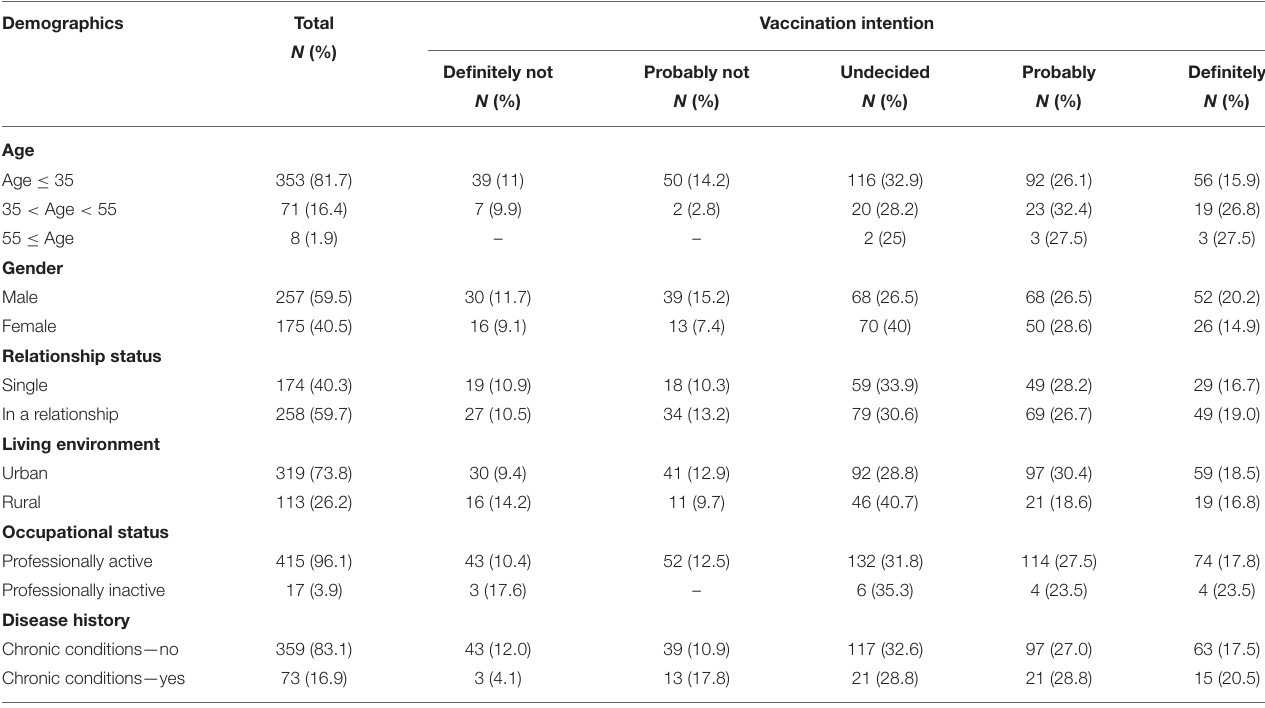
TABLE 2 | Sociodemographic characteristics and COVID-19 vaccination